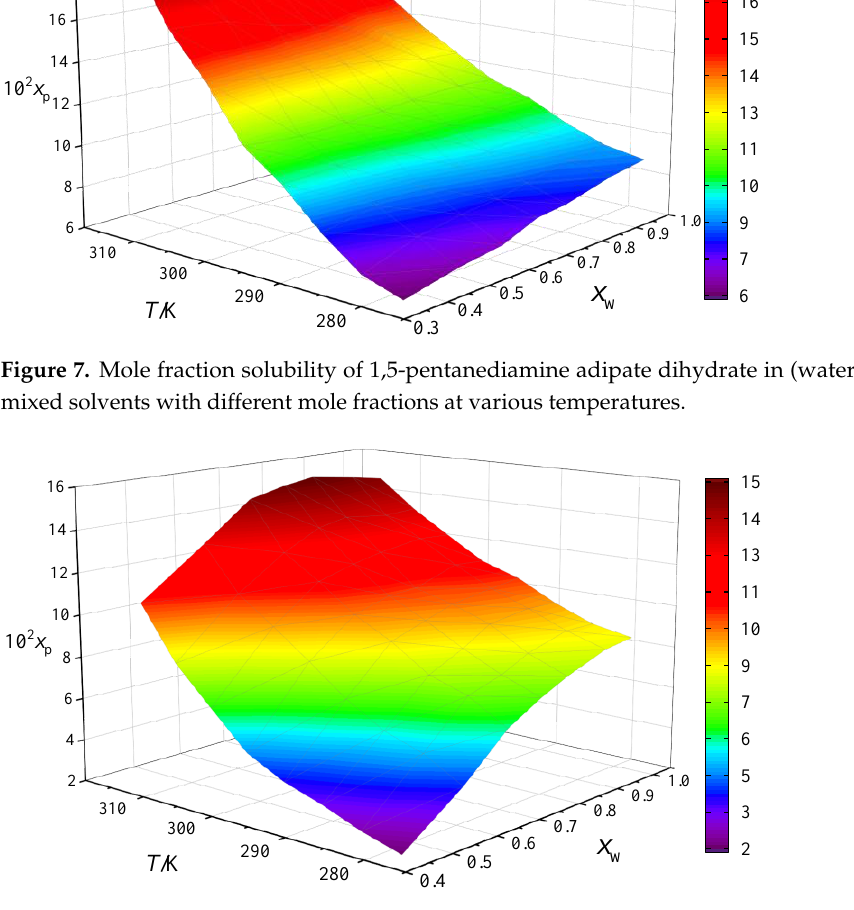
Figure 8. Mole fraction solubility of 1,5-pentanediamine adipate dihydrate in (water + ethanol) mixed solvents with different mole fractions at various temperatures.